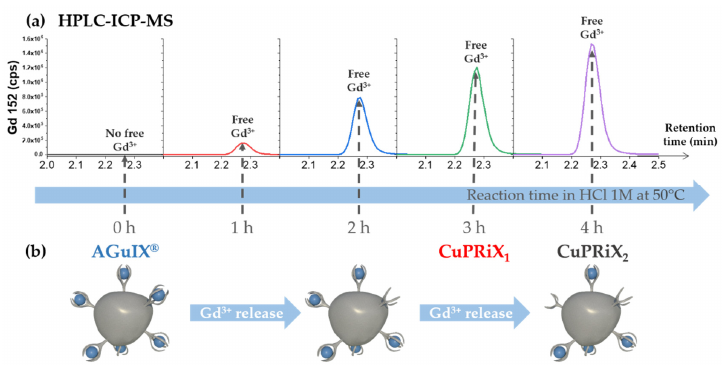
Figure 1. ( a ) Increase in free gadolinium (retention time close to 2.3 min) at different time points of the reaction followed by HPLC—ICP/MS. ( b ) Schematic view of the impact of the process on the nanoparticle starting from AGuIX ® to obtain CuPRiX 1 (3 h of reaction) and CuPRiX 2 (4 h of reaction).